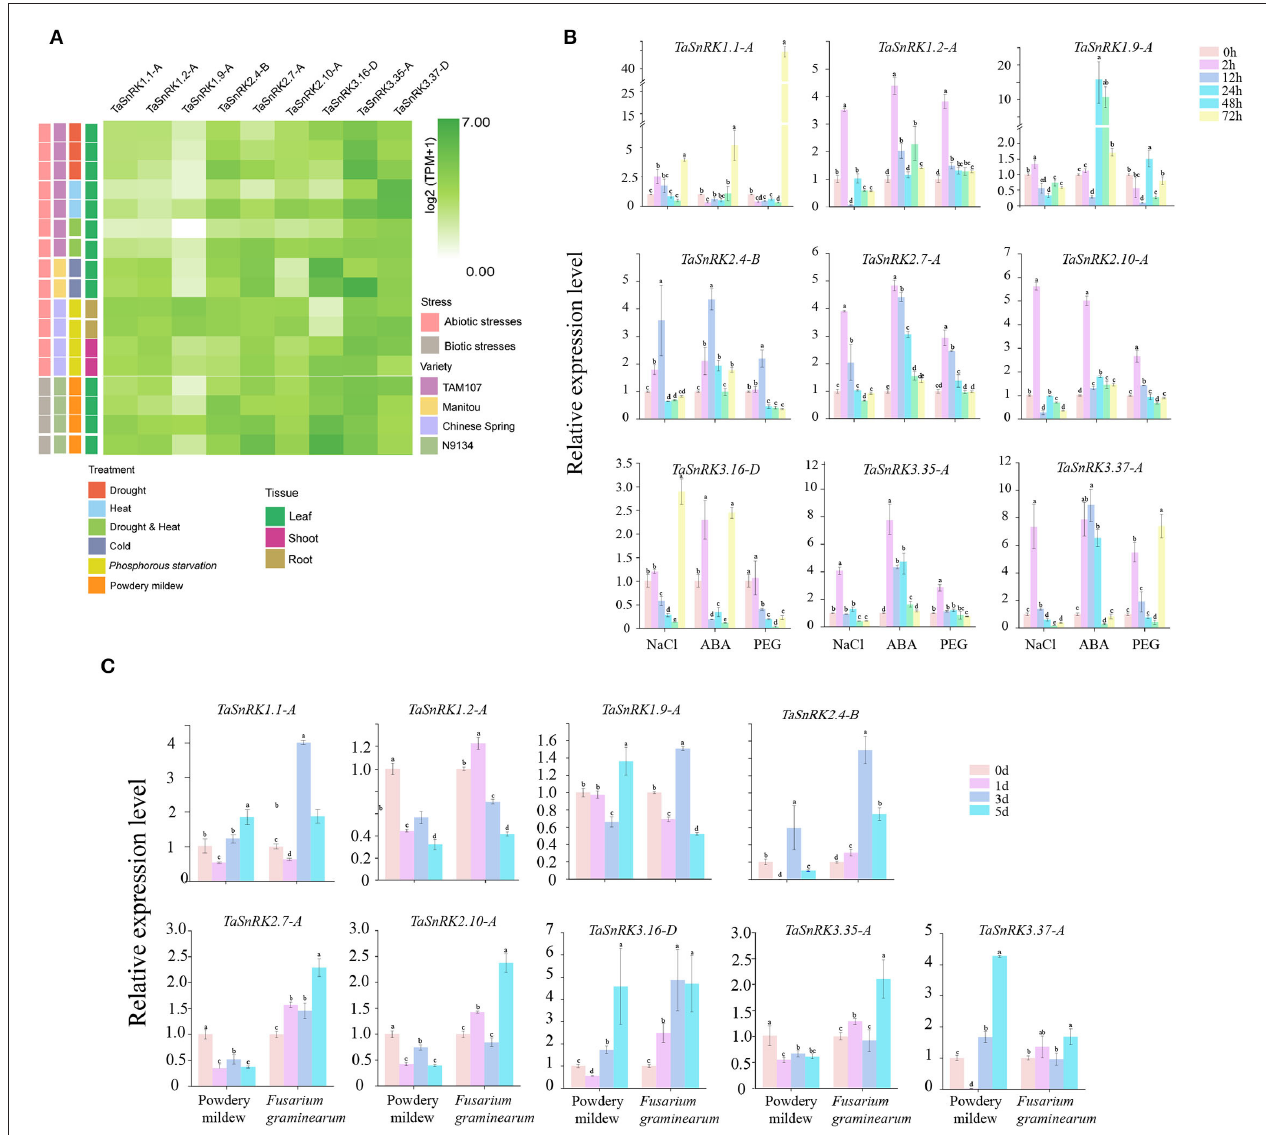
FIGURE 5 | Expression patterns of nine selected TaSnRK genes under abiotic and biotic stresses. (A) Expression levels of nine TaSnRK genes under multiple abiotic stresses involving PEG 6000 stress, cold stress, drought and heat combined stress, drought stress, heat stress, phosphorous starvation, and biotic stress involving powdery mildew infection. (B) Expression patterns of the nine TaSnRK genes under abiotic stresses including NaCl, ABA, and PEG treatment. (C) Expression of the nine TaSnRK genes under biotic stresses, including powdery mildew and Fusarium graminearum infection. The relative expression levels were determined by the 2 − 11 ct method. Significant differences at P <